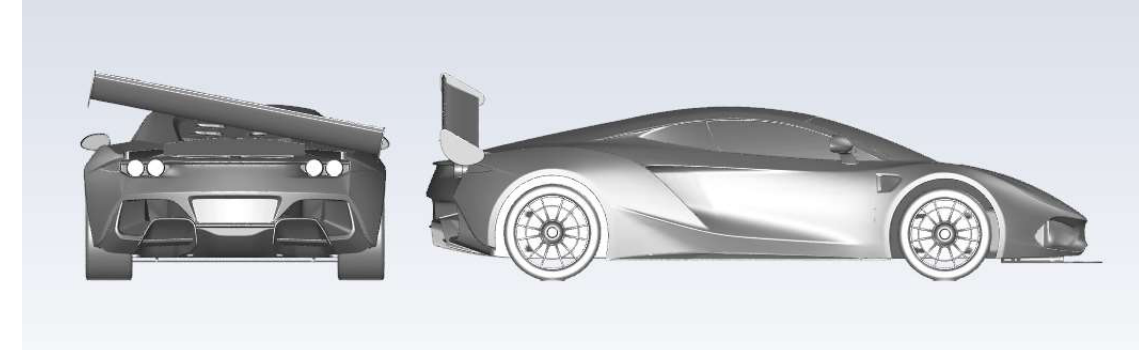
Figure 17. Vehicle geometry with a slanted wing at the rear and a splitter under the front of the body. Table 1. Parameters of the car without spoiler and without splitter.